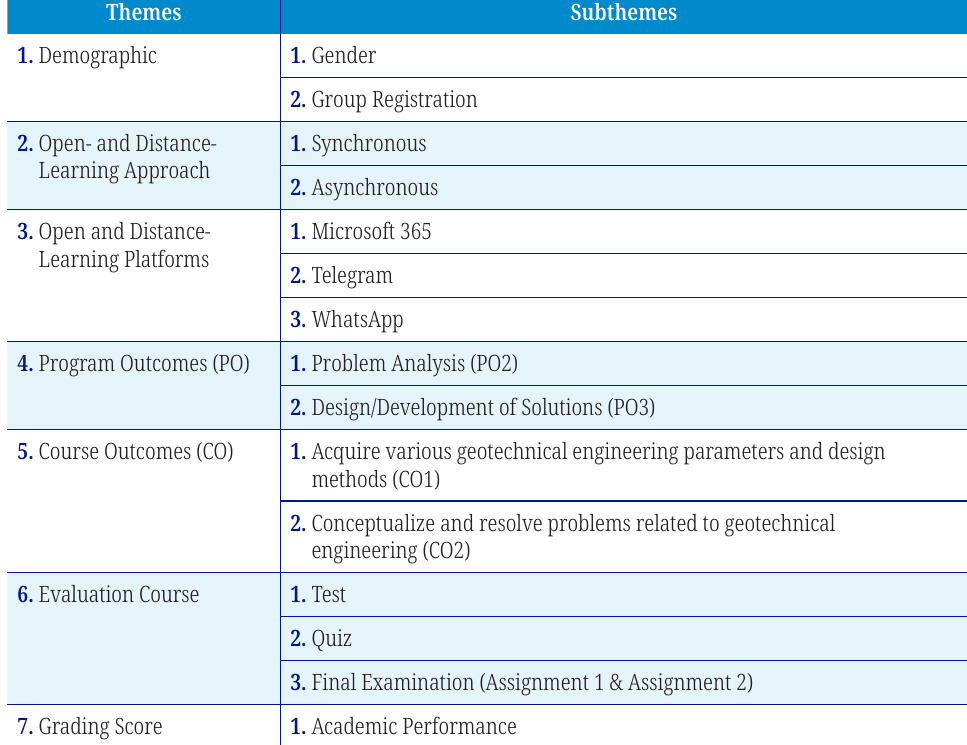
Table 1. Types of evaluations measured by themes according to course and program outcomes